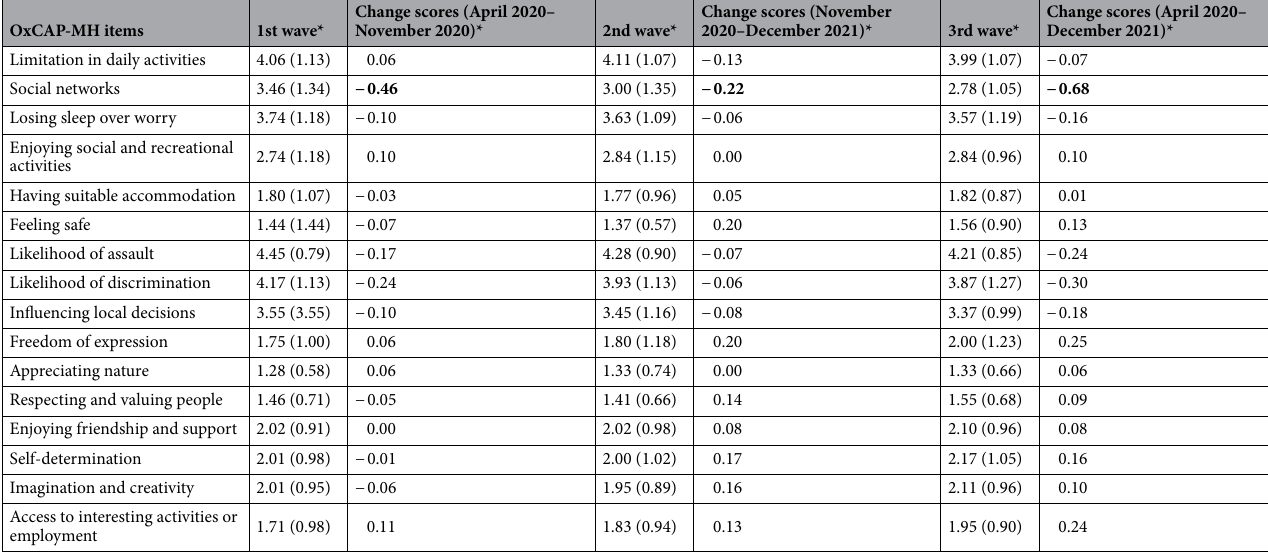
Table 3. Limitations in capability dimensions based on scores of the OxCAP-MH items at (and between) three waves of data collection (n = 87). *Higher OxCAP-MH scores mean higher capabilities in that particular item (on a 1–5 likert scale); Statistically significant (p < 0.05) associations in bold.